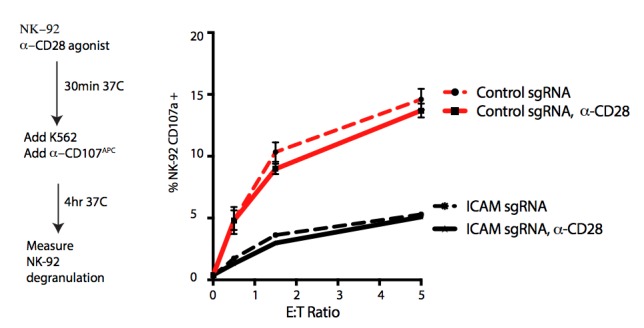
Effect of CD28 agonism on NK-92 degranulation.